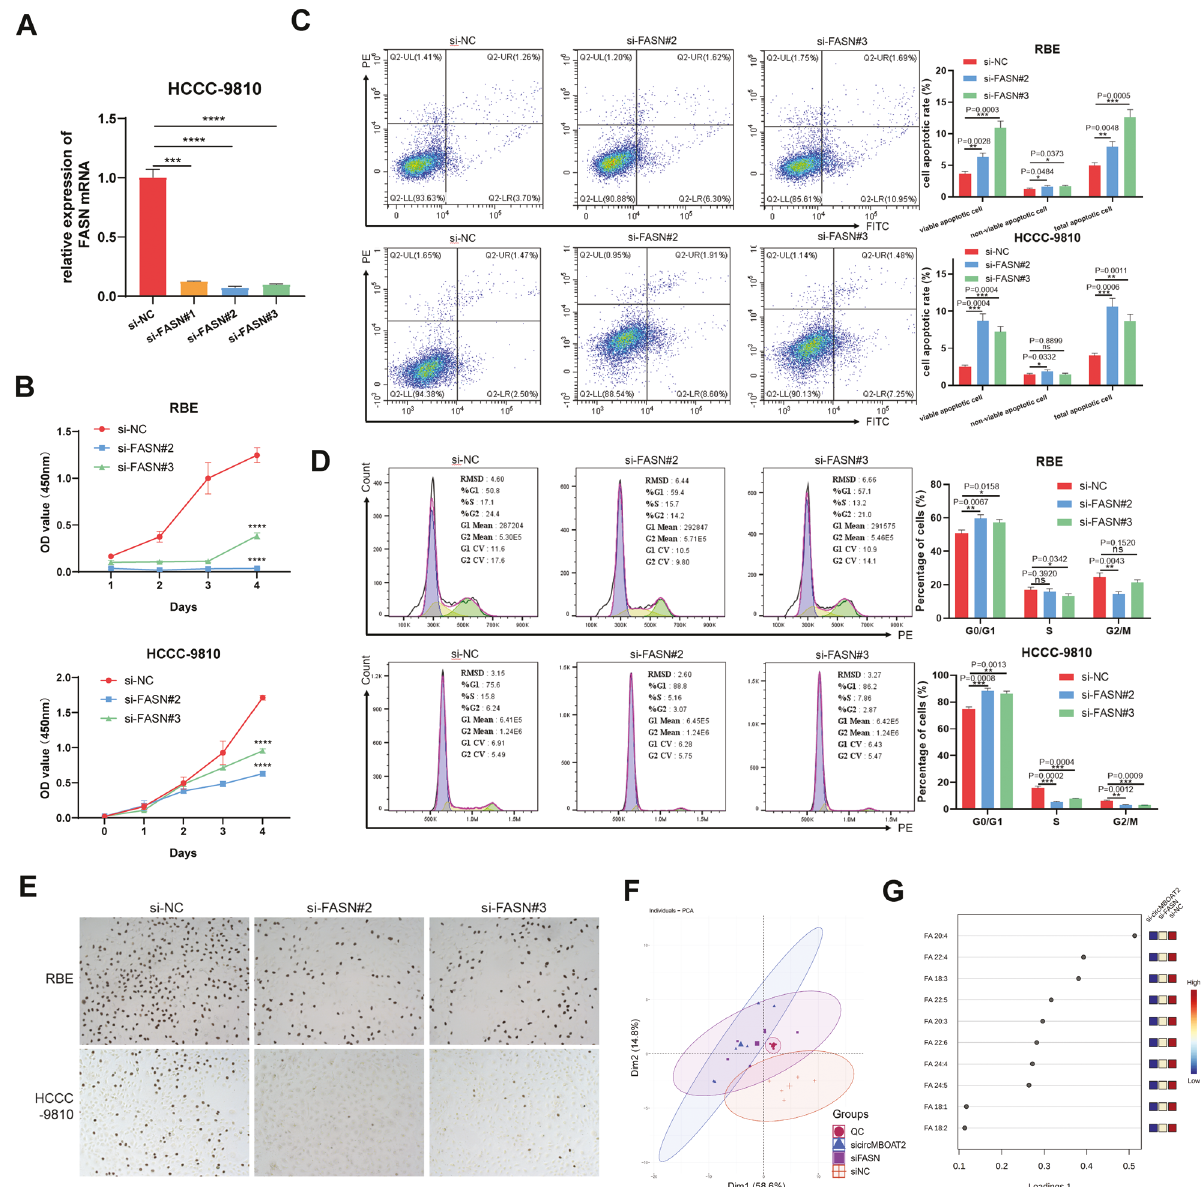
Fig. 7 Arachidonic acid (C20:4) and adrenic acid (C22:4) intervene in ICC progression in circMBOAT2/PTBP1/FASN axis. A The qRT-PCR method was applied to detect the mRNA levels of FASN after transfected with si-NC, si-FASN#1, si-FASN#2, and si-FASN#3. The expression of FASN was normalized to β -actin. B CCK8 assay for cell proliferation capacity after FASN-knockdown in RBE and HCCC-9810 cells. C Flow Cytometry was applied to determine the early and late stages of apoptosis rate after FASN-knockdown in RBE and HCCC-9810 cells. D Flow cytometry was applied to determine the percentage cell phase distribution, including G0/G1, S, and G2/M phases after FASN-knockdown in RBE and HCCC-9810 cells. E EdU proliferation assay was used to detect the levels of DNA synthesis in RBE and HCCC-9810 cells after FASN knockdown. The original magni fi cation was 200×. F HCCC-9810 cells were transfected with si-NC, si-circMBOAT2#1, or si-FASN#2 for lipid principal component analysis (PCA). G VIP scores plot in loadings 1 of PLS-DA. Signi fi cant differences between groups were analyzed by t -test. Error bars represent the means ± SEM of three independent